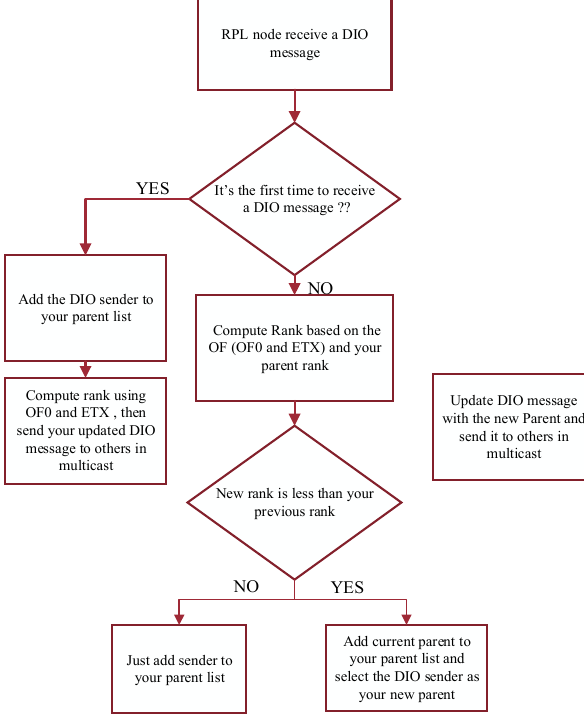
Figure 3. RPL DIO Message Mechanism.